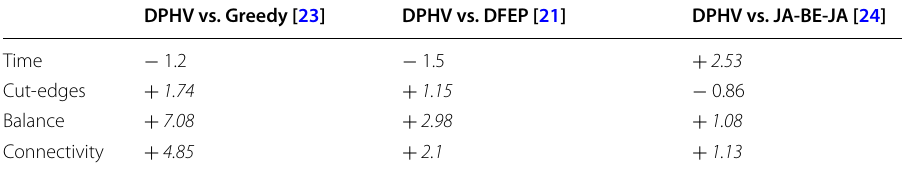
Table 3 DPHV performance ratio compared to DFEP [21], JA-BE-JA [24] and Greedy [23] DPHV vs. Greedy